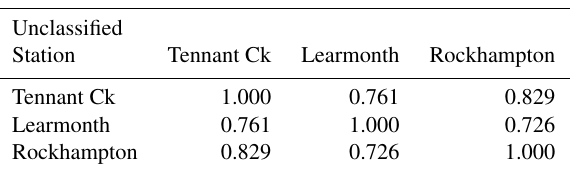
Table 7. Pearson’s correlation coefficient between all unclassified station pairs, for stations with time series of 60 months or greater.